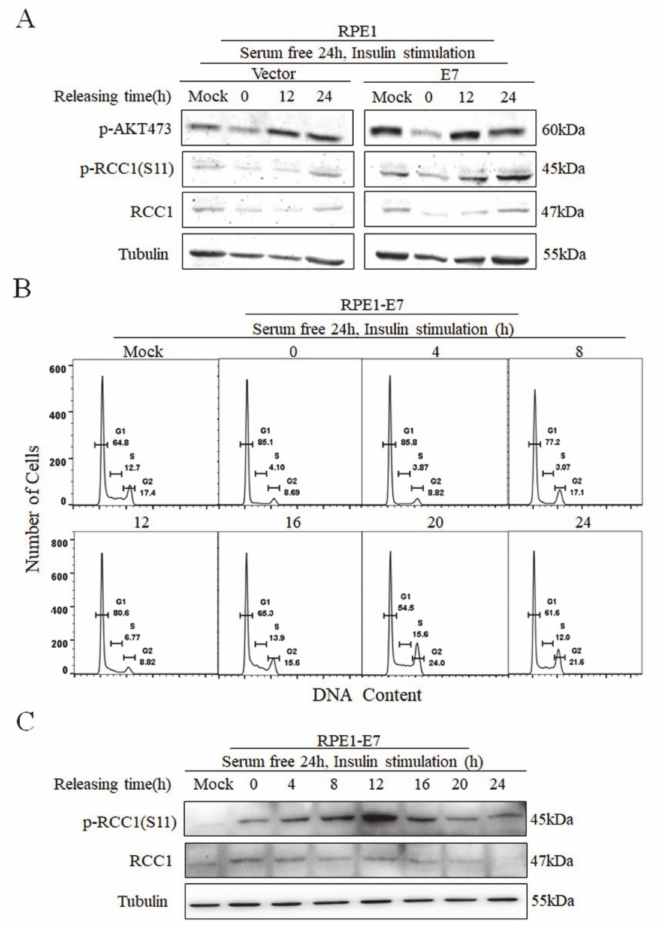
Figure 3. Phosphorylation of RCC1 S11 reached peak in M phase. ( A ) RPE1-E7 cells and control cells were deprived of serum for 24 h, then insulin was added, and cells were harvested at the indicated time. Expression of p-AKT 473, p-RCC1(S11), RCC1 were monitored by Western blot. ( B , C ) Flow cytometric and Western blot analysis of RPE1-E7 cells with serum starvation for 24 h, then insulin stimulated and harvested at different time points. Data shown are